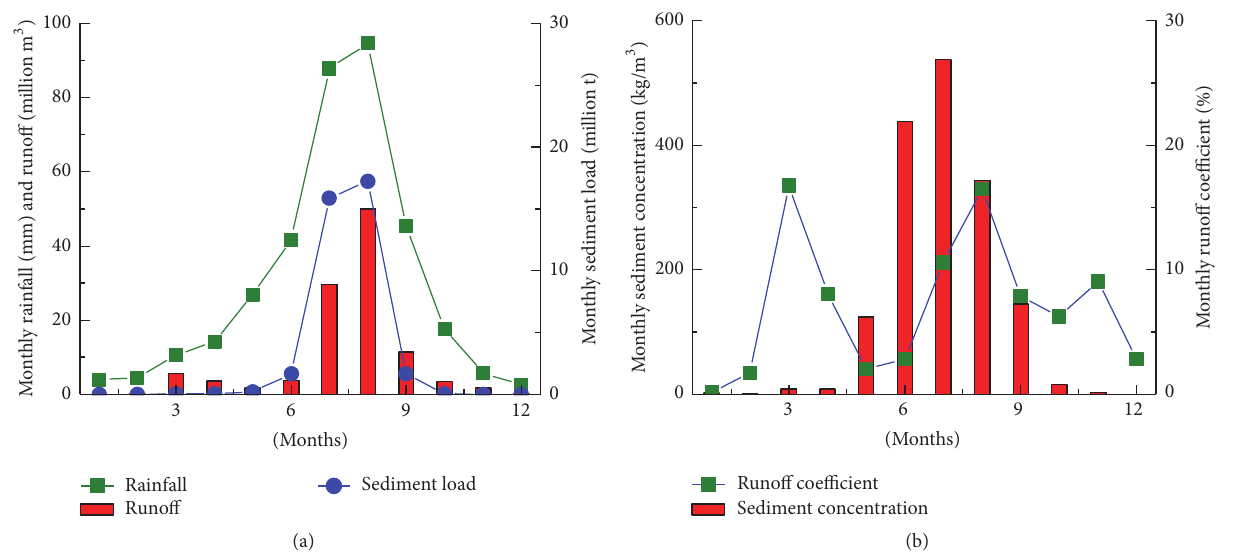
Figure 2: Monthly mean runoff and sediment load at Huangfu station ((a) monthly precipitation, runoff, and sediment load; (b) monthly runoff coefficient and sediment concentration).